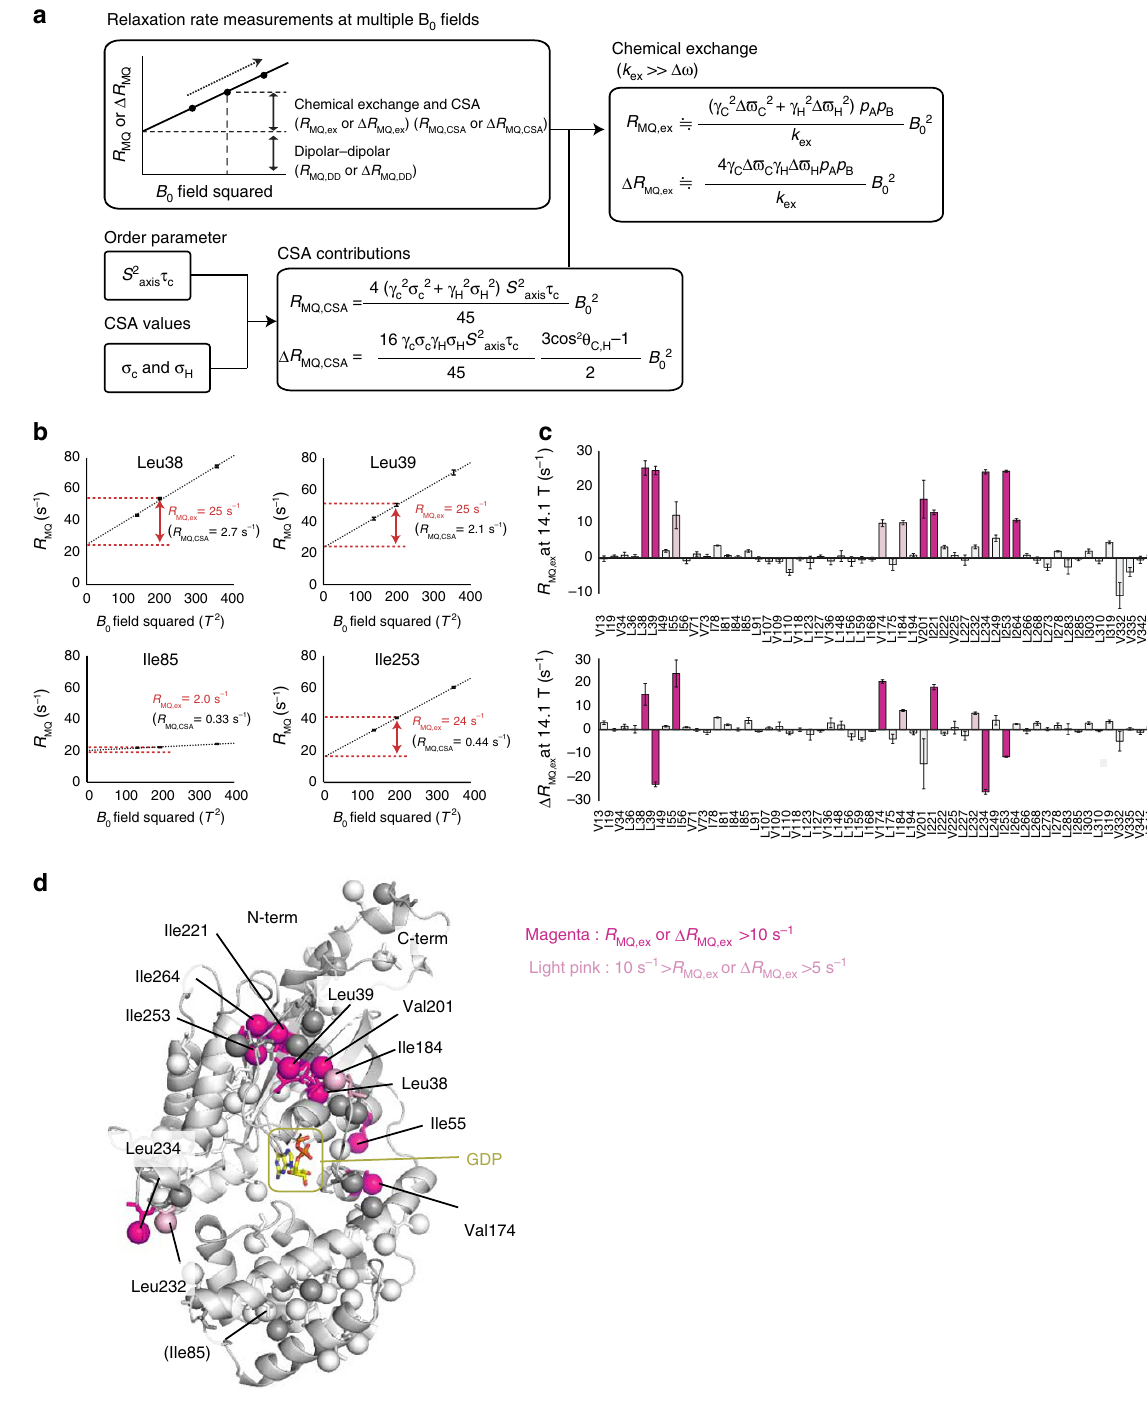
Figure 2 | Magnetic field-dependent MQ relaxation analyses of the wild-type G a -GDP. ( a ) Schematic representation of the magnetic field-dependent MQ relaxation analyses. ( b ) Plots of the R MQ rates of Leu38, Leu39, Ile85 and Ile253 against the square of the static magnetic fields. The obtained R MQ,ex rates at 14.1Tesla (600MHz 1 H frequency) are shown. The error bars represent s.d. of fitting errors, estimated from Monte Carlo simulations using uncertainties in peak intensities. ( c ) Plots of the R MQ,ex (top) and D R MQ,ex (bottom) rates at 14.1Tesla. The error bars represent s.d. of fitting errors, estimated from Monte Carlo simulations using uncertainties in peak intensities. The methyl groups with R MQ,ex or D R MQ,ex rates larger than 10s (cid:2) 1 are coloured magenta, and those within the 5–10s (cid:2) 1 range are coloured pink. The small negative values of the R MQ,ex rates are due to the overestimations to the CSA contributions to the MQ relaxation rates, originating from systematic errors in the measurements. We suppose that the relatively large negative value of the R MQ,ex rate of Val332 is due to its low signal-to-noise ratio and its very large dipolar contribution to the MQ relaxation rate (44s (cid:2) 1 ), which hampers the reliable measurement of the 1 H- 13 C cross-correlated relaxation rate (1.9s (cid:2) 1 on average). ( d ) Mapping of the methyl groups with significant R MQ,ex or D R MQ,ex rates on the structure of G a -GDP (PDB ID: 1GDD) 17 . The methyl groups with significant R MQ,ex or D R MQ,ex rates are coloured in the same manner as in c . Methyl groups with no data are coloured